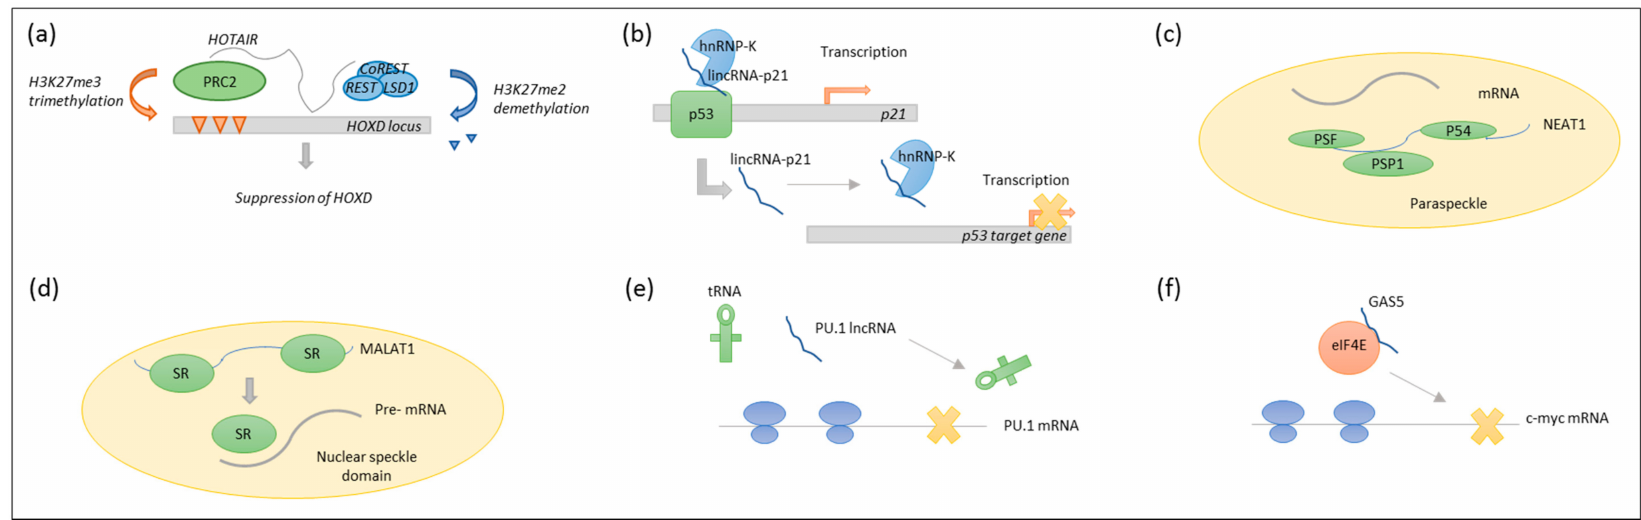
Figure 2. Cellular functions of lncRNAs. ( a ) LncRNAs as scaffolds for histone modification enzymes. Homeobox transcript antisense intergenic RNA ( HOTAIR ) tethers both polycomb repressive complex 2 (PRC2) and coREST/REST/LSD1, thereby specifying the pattern of histone modification on target genes. ( b ) lncRNAs can regulate gene expression in cis or in trans . Shown here is large intergenic non-coding RNA p21 (lincRNA-p21) , which act in cis as a coactivator for p53-dependent transcription of p21, or in trans by interacting with heterogenous nuclear ribonucleoprotein K (hnRNP-K) to mediate repression of distant p53 target genes ( c ) LncRNAs such as nuclear enriched abundant transcript 1 (NEAT1) can retain mRNAs in the nucleus by associating with paraspeckle proteins such as PSF, PSP1, and p54. ( d ) In tissue-specific alternative splicing, lncRNAs participate by recruiting serine/arginine splicing factors (SR) to nuclear speckles, and thereby to the target pre-mRNAs, as shown for metastasis associated lung adenocarcinoma transcript 1 (MALAT1) . ( e ) LncRNAs can serve as decoys inhibiting protein synthesis, here exemplified by antisense lncRNA PU.1 , which blocks transfer RNA (tRNA) recruitment by inhibiting elongation through translation elongation factor eEF1a1, thereby inhibiting hematopoietic transcription factor PU.1 mRNA translation. ( f ) LncRNA growth-specific 5 (GAS5) interacts with translation initiation factor eIF4E to suppress the translation of c-myc